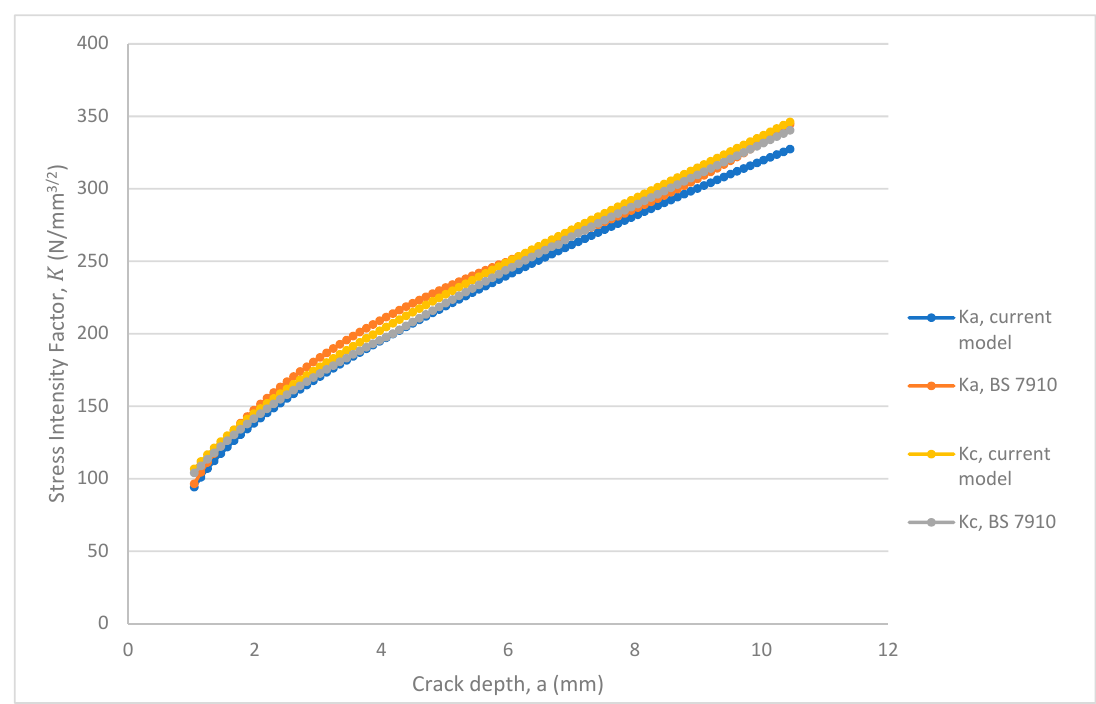
Figure 27. SIFs at the deepest point ( K a ) and surface point ( K c ) for an internal semi-elliptical crack in a pipe under cyclic tension (initial a / c = 1.0).